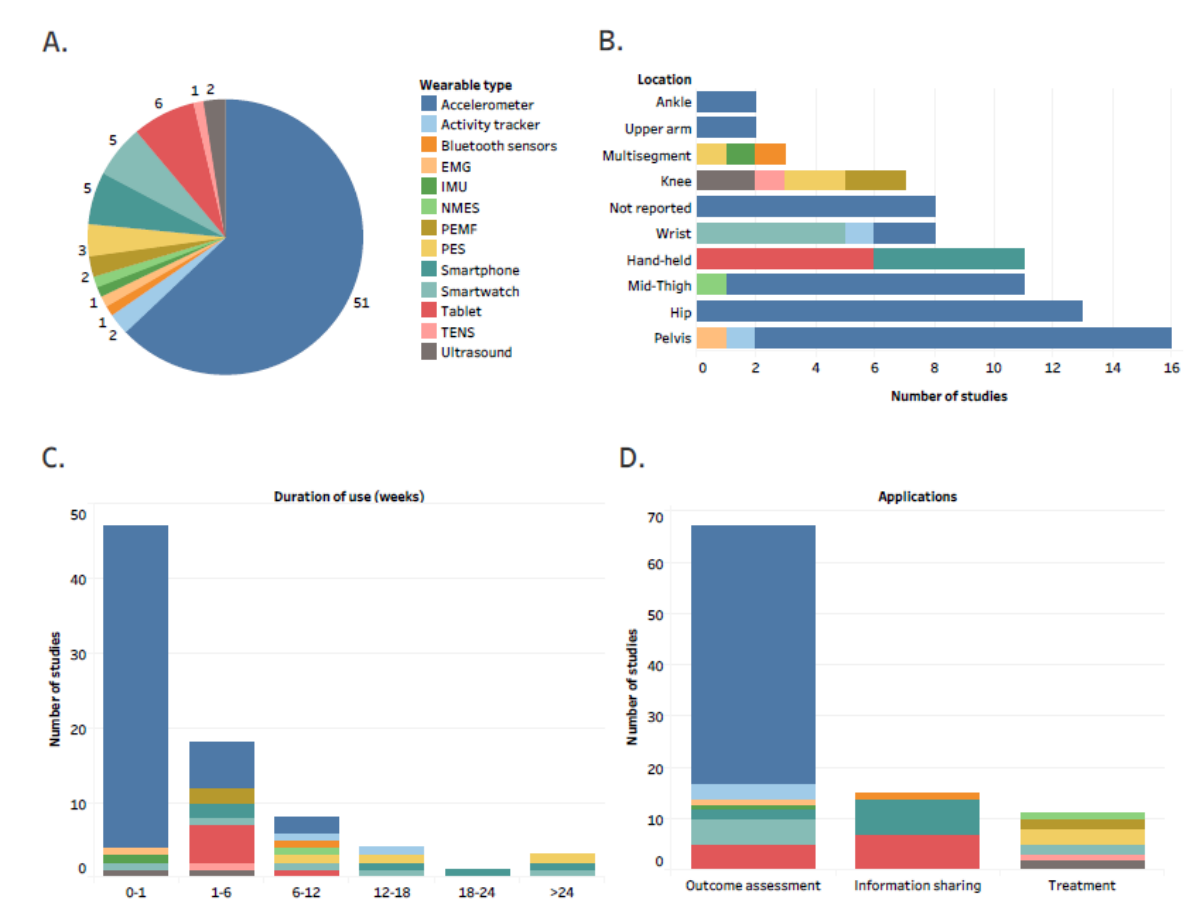
Figure 3. Details regarding type and applications of wearable technology; the number of studies by: ( A ) type of wearable technology; ( B ) location of body attachment stratified by type of wearable device; ( C ) duration of wearable use stratified by type of wearable device; ( D ) applications of wearable technology stratified by type of wearable device; Abbreviations: PES, pulsed electrical stimulation device; PEMF, pulsed electromagnetic field device; EMG, electromyography; IMU, inertial measurement unit; NMES, neuromuscular electric stimulation device; TENS, transcutaneous electrical nerve stimulation device; Interactive version of the figure with all the study references is located here: https://public.tableau.com/app/ profile/tomasz.cudejko/viz/Figure3_16324888236280/Figure3 (accessed on 19 October